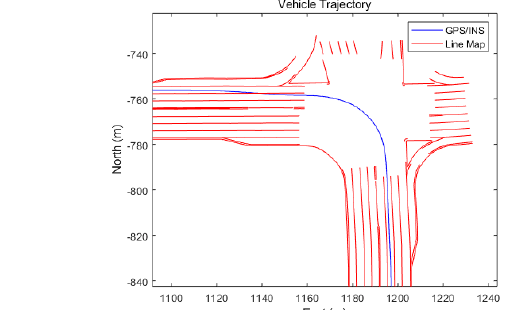
Figure 10. Coordinate quality (CQ) of Ekinox2-D RTK/INS. Figure 11 shows the result of dividing the vehicle driving trajectory into lane change section and lane keeping section. The blue stars represent the lane change section, and the green stars represent the lane keeping section. Therefore, the lateral position error of the RTK/INS can be obtained by calculating the distance between the two lanes and the RTK/INS position in the green section. At this time, it is assumed that the vehicle travels along the center of the two lanes in the green section. Figure 12 shows the lateral position error of the RTK/INS for a high-precision digital map in the green section.